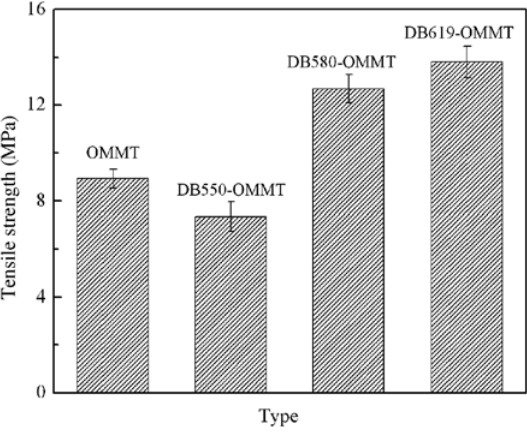
Figure 3 Different kinds of organophilic montmorillonite loading on the tensile strength of the composites.